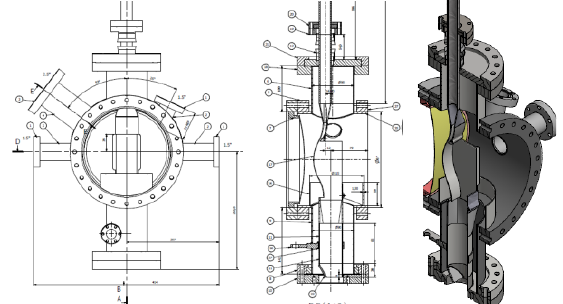
Fig. 3. The final design of the full power wide nozzle and the nozzle chamber